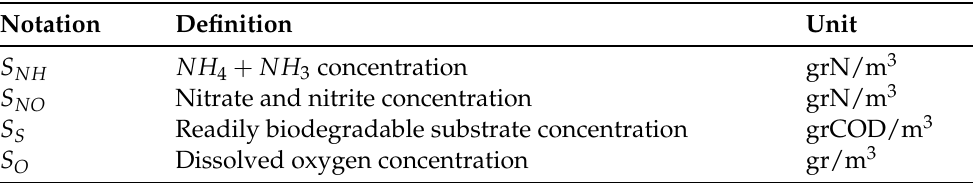
Table 1. List of state variables of the